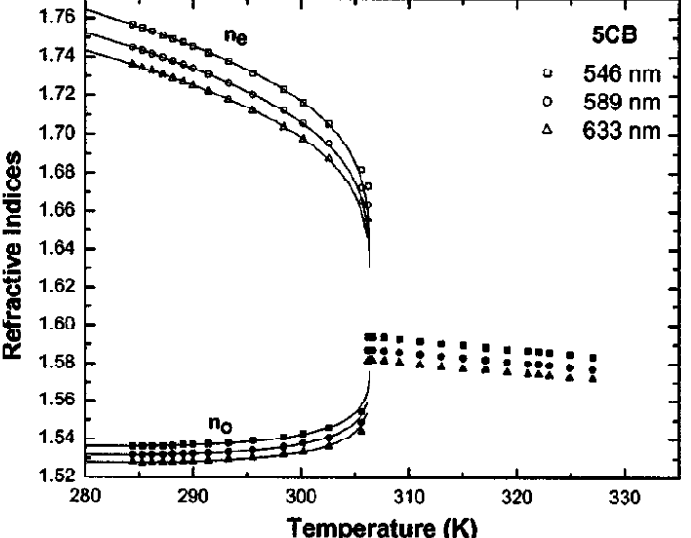
Figure 4. Temperature-dependent refractive indices of 5CB at  = 546, 589 and 633 nm. Squares, circles, and triangles are experimental data for refractive indices measured at  = 546, 589 and 633 nm, respectively. Figure 4 is adapted from reference